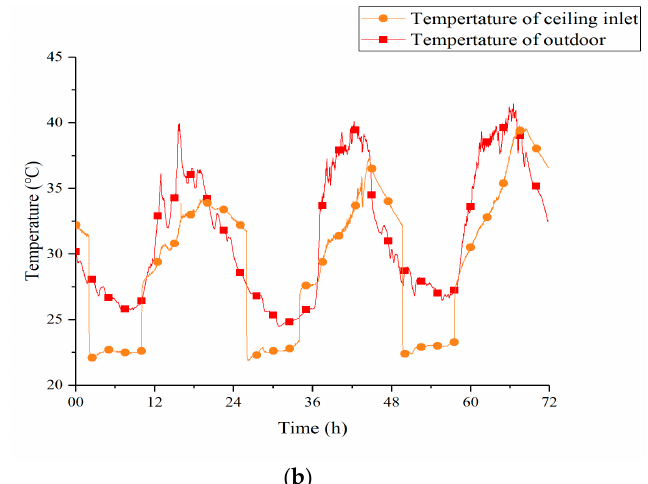
Figure 7. Temperature curves of outdoor and ceiling inlet under two strategies ( a ) 12 h; ( b ) 8 h.